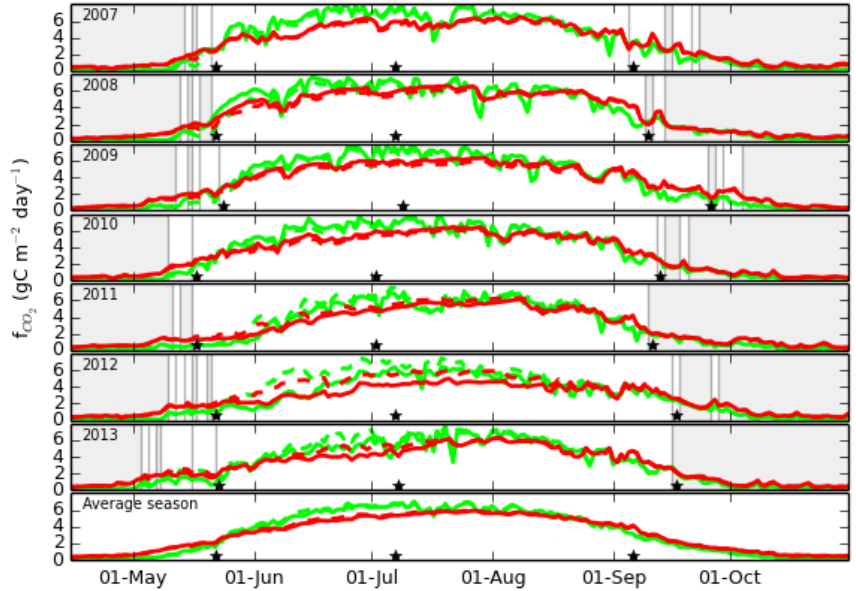
Figure 10. GPP (green) and TER (red) simulated with SiBCASA without (solid lines) and with assimilation (dashed lines) of ASCAT soil moisture for Yakutsk